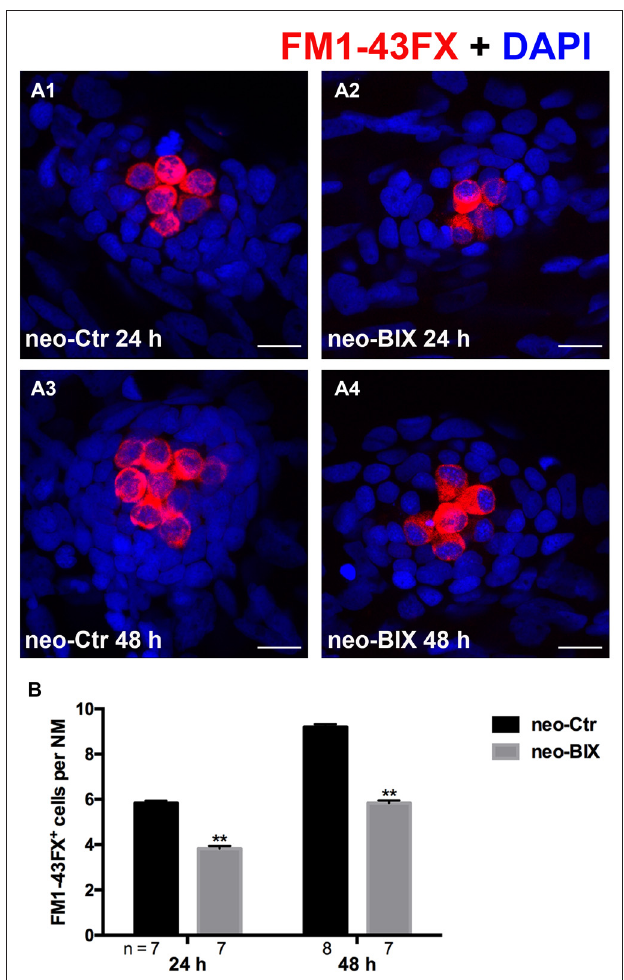
FIGURE 3 | BIX01294 treatment reduces FM1-43FX + cells in the course of regeneration. (A) The functional HCs of 5 dpf wild-type larvae are stained with FM1-43FX (red) with or without exposure to BIX01294 for 24 h or 48 h after neomycin damage for 1 h. Nuclei are stained with DAPI (blue). Scale bars = 10 µ m. (B) The average number of FM1-43FX + cells per NM in larvae treated with or without 20 µ M BIX01294 for 24 h or 48 h after neomycin damage. Bars are mean ± SEM, and n = total number of embryos. ∗∗ p < 0.001.